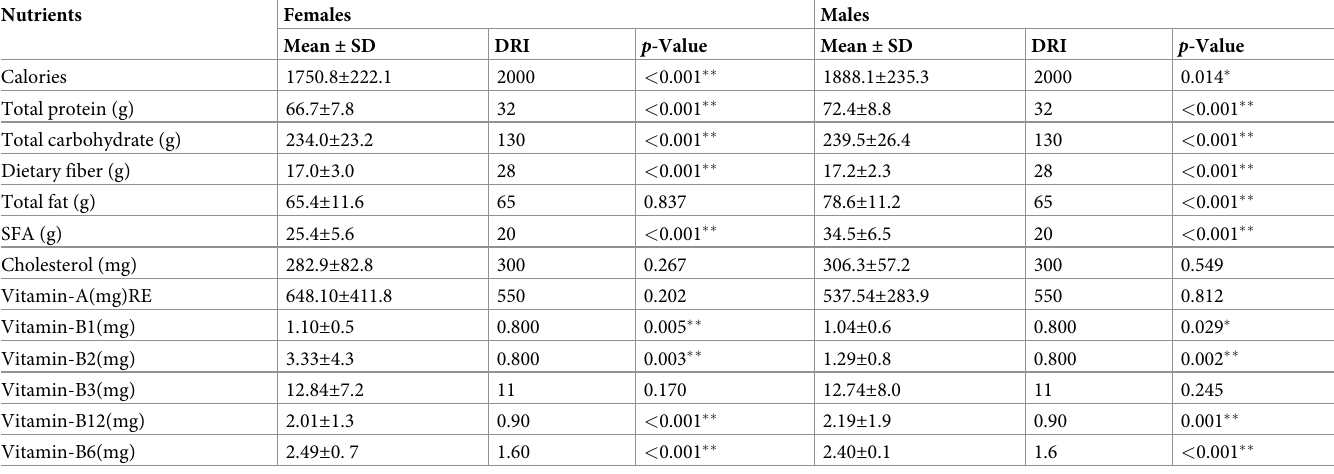
Table 3. Nutrients intake of depressed males and females compared to daily-recommended intake (DRI).